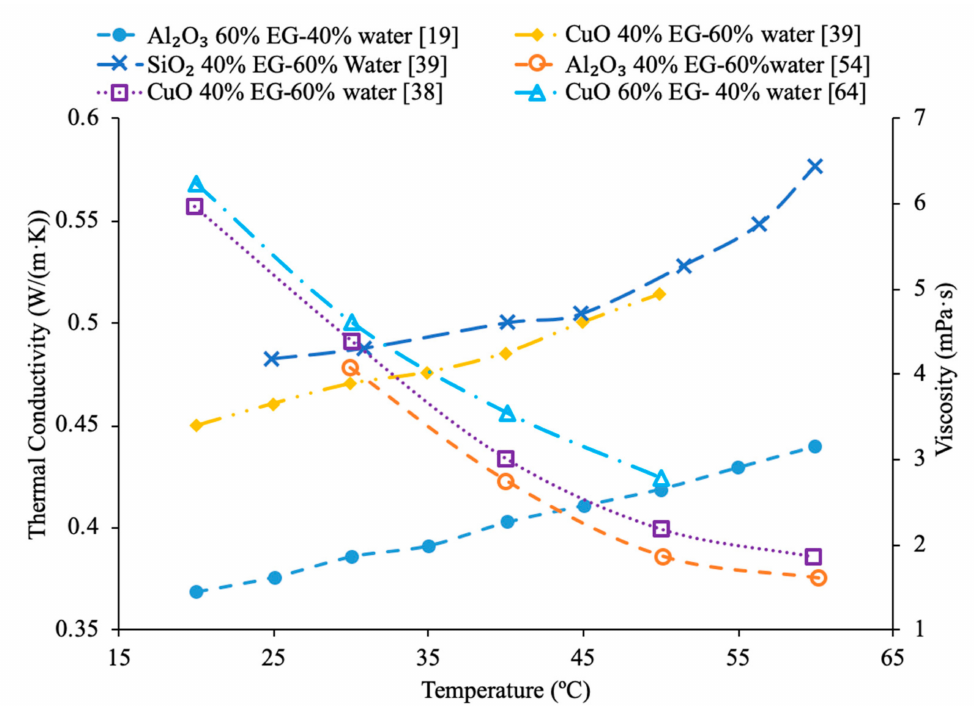
Figure 24. Thermal conductivity (increasing with temperature) and viscosity (decreasing with temperature) of various nanofluids with a base liquid that varies in percent ethylene glycol (EG) and percent water